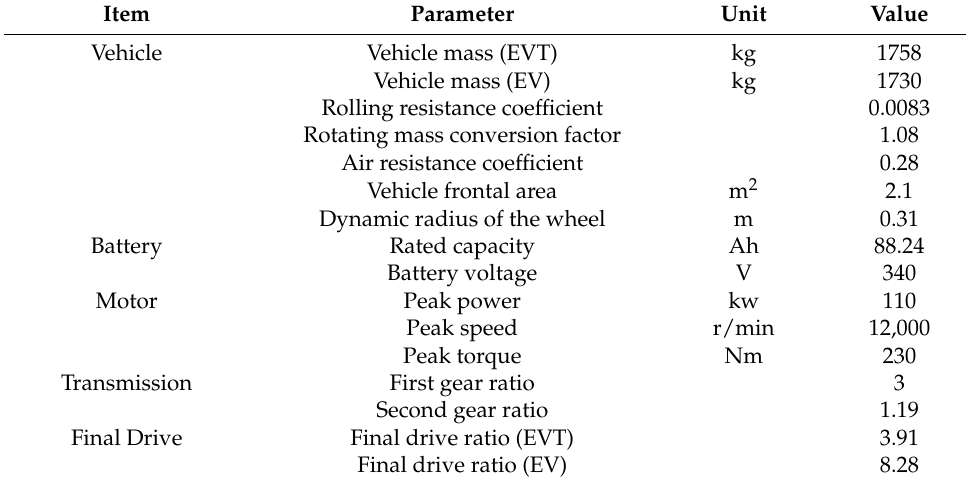
Figure 1. Configurations of EVT and EV: ( a ) EVT; ( b ) EV. Table 1. The parameters of EVT and EV.